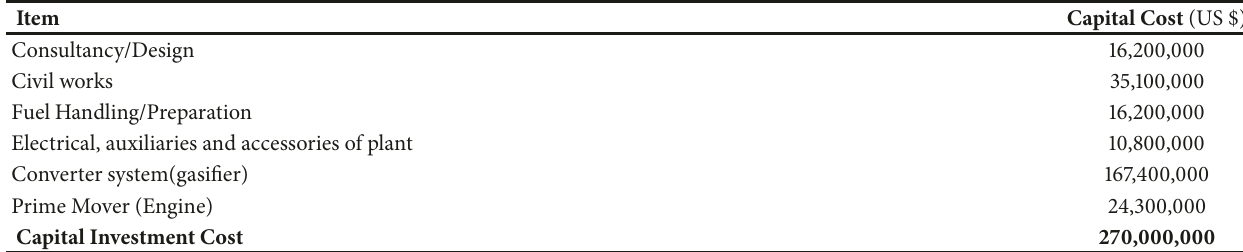
Table 15: Biomass gasification capital investment cost breakdown.